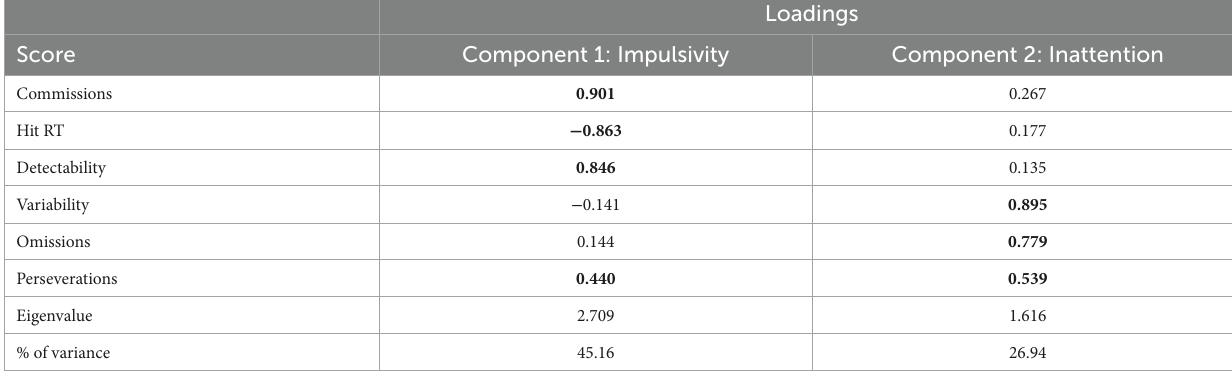
TABLE 2 The orthogonally rotated solution to the principal components analysis of CPT